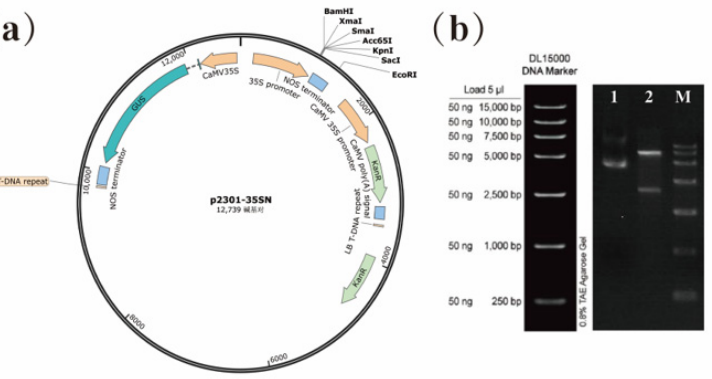
Figure 6. Construction of expression vector of PmKNAT2-a and PmKNAT2-b . ( a ) Vector mapping of p2301-35SN; ( b ) Construction of p2301- PmKNAT-a vector. M is Marker; lane 1 is p2301- PmKNAT2/6-a vector plasmid; lane 2 is enzyme digestion assay (restriction enzyme: BgllI ).